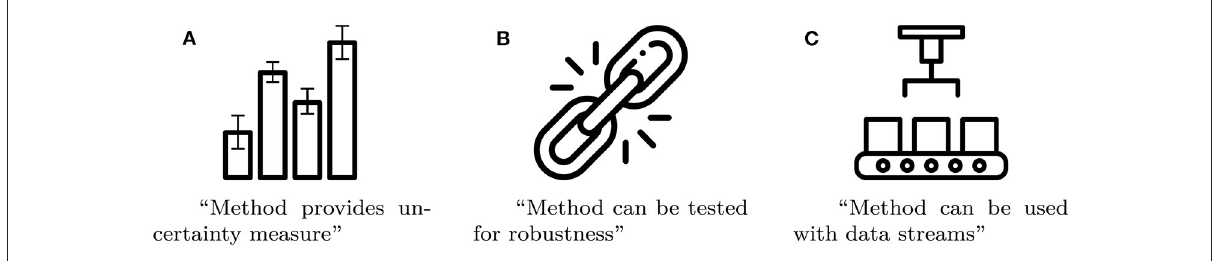
FIGURE4 Three examples of badges as a compact way to summarize a method’s noteworthy properties (Images taken from Flaticon.com). (A) Method provides un-certainty measure. (B) Method can be tested for robustness. (C) Method can be used with data streams.